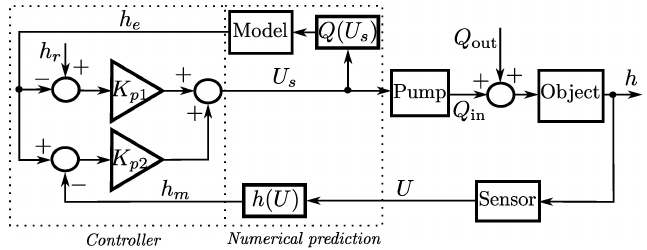
Figure 8. Block diagram of the closed-loop control system (see